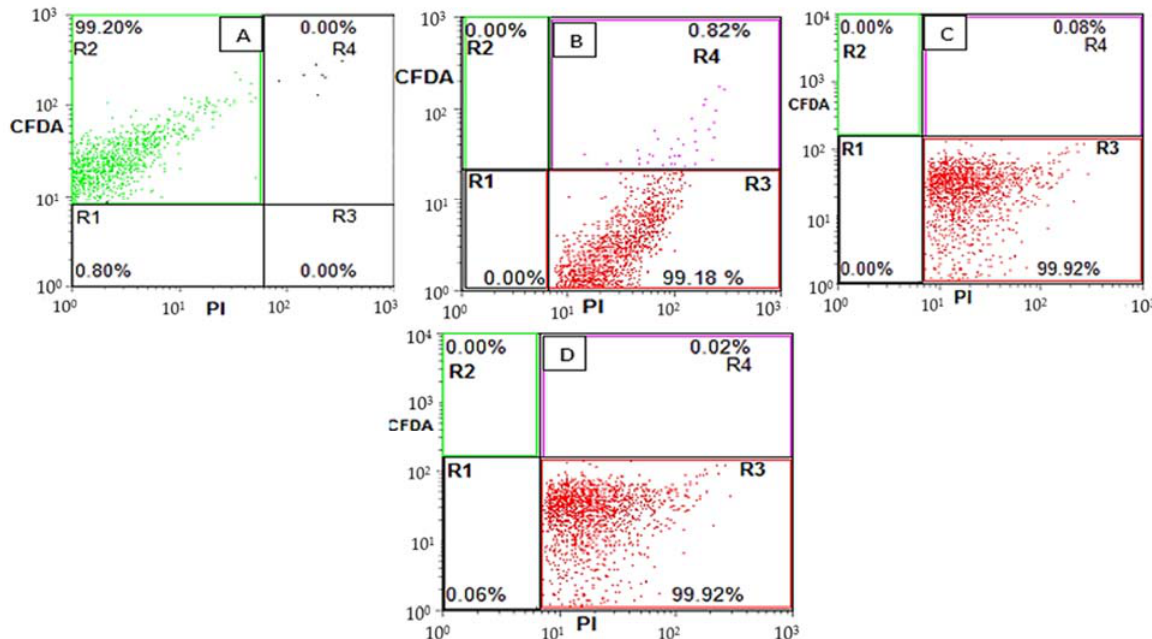
Figure 5. Flow cytometric dot plot distribution of E. coli bacteria upon treatment with 0 ( A ), 300 ( B ), 600 ( C ) and 900 ( D ) µ m EU nano-emulsion after 36 h of treatment. R1 (cell debris), R2 (viable cells), R3 (membrane-damaged cells) and R4 (sublethal cells).